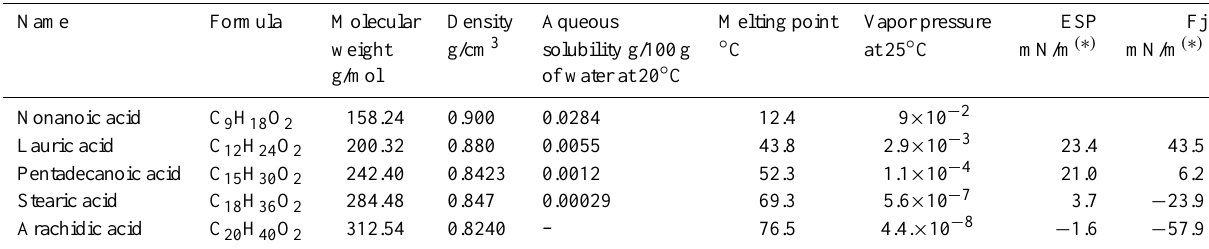
Table 1. Properties of the